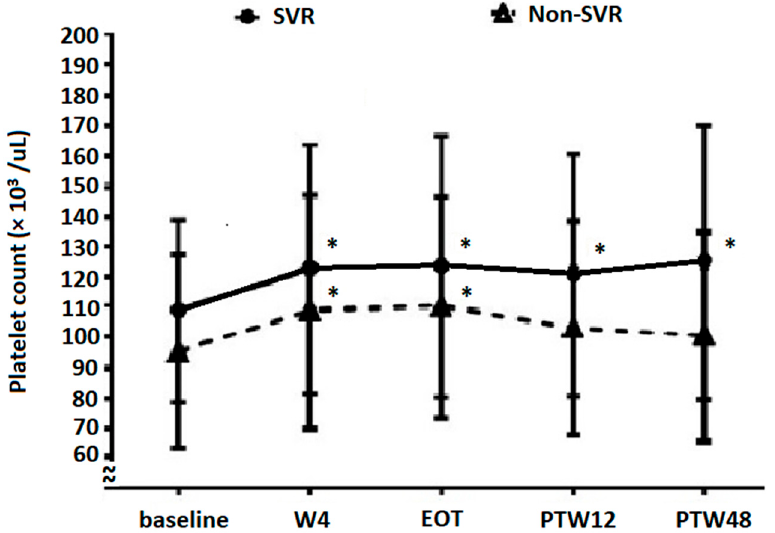
Figure 3. The evolution of platelet counts in patients with SVR12 and without SVR12. * Platelet counts are significantly increased compared with baseline levels (in SVR patients, p < 0.001 for W4 vs. baseline, EOT vs. baseline, PTW12 vs. baseline, and PTW48 vs. baseline; in non-SVR patients, W4 vs. baseline, p < 0.05; EOT vs. baseline, p = 0.003; PTW12 vs. baseline, p = 0.115; and PTW48 vs. baseline, p = 0.290). W4, week 4; EOT, end-of-treatment; PTW12, 12 weeks post-treatment follow-up; PTW48, 48 weeks post-treatment